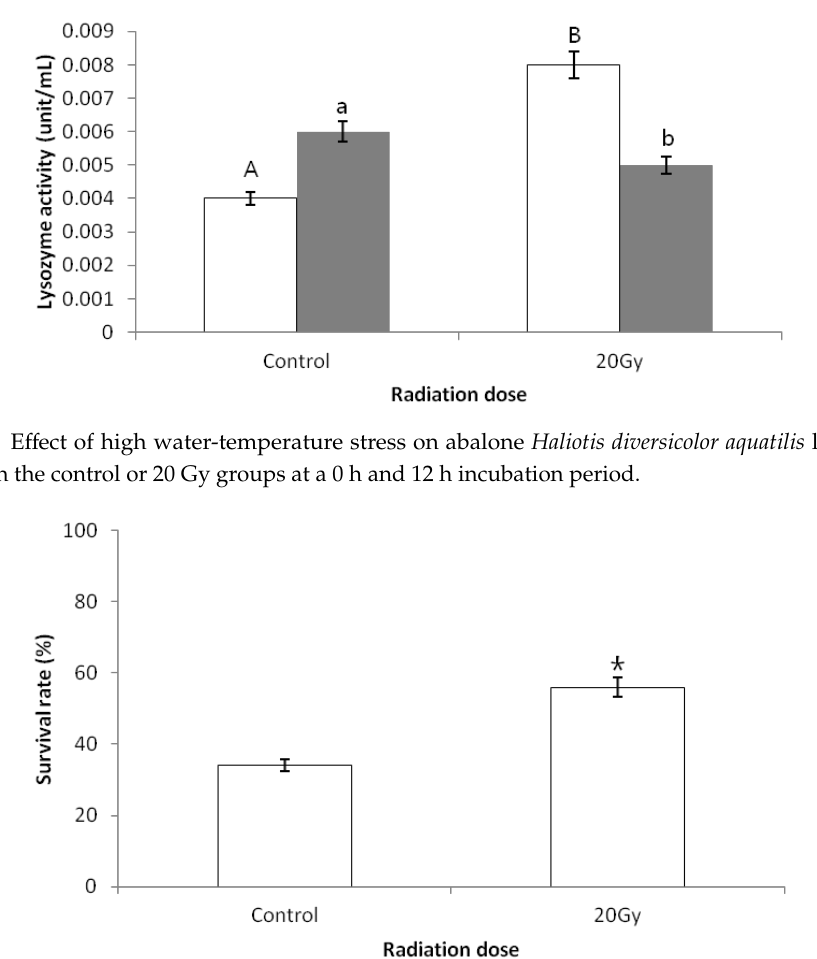
Figure 7. Survival of abalone Haliotis diversicolor aquatilis reared with different doses of radiation at 12 h after exposure to high-water temperature stress. * p < 0.05 for control.